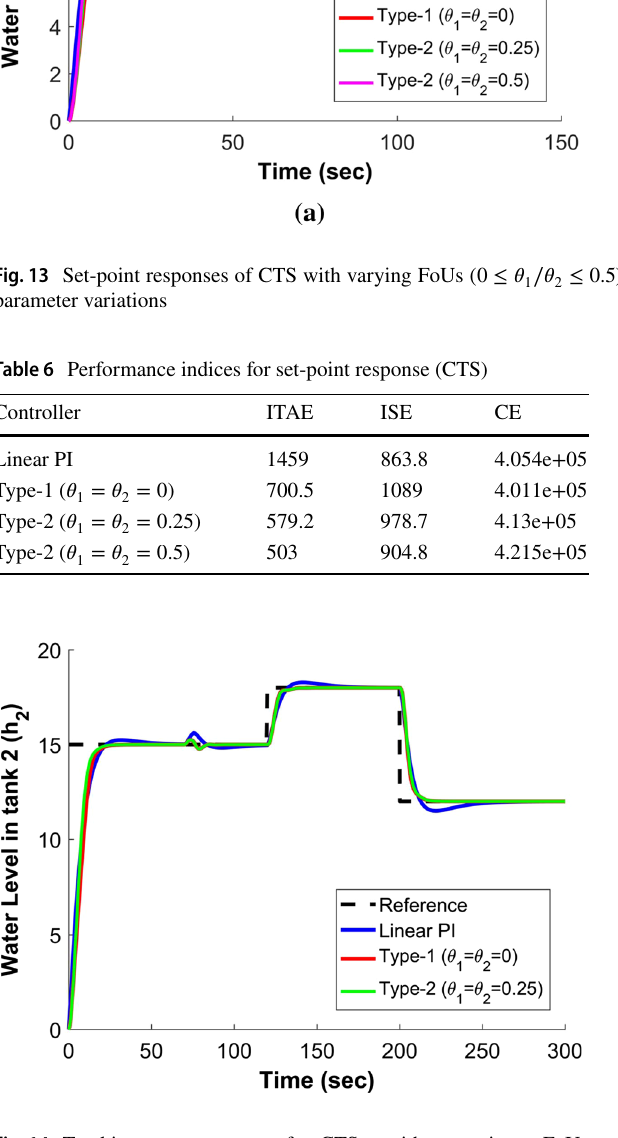
Fig. 14 Tracking responses of CTS with varying FoUs 0 ≤ 𝜃 0.5 ( ) in the presence of input disturbance 1 ∕ 𝜃 2 ≤